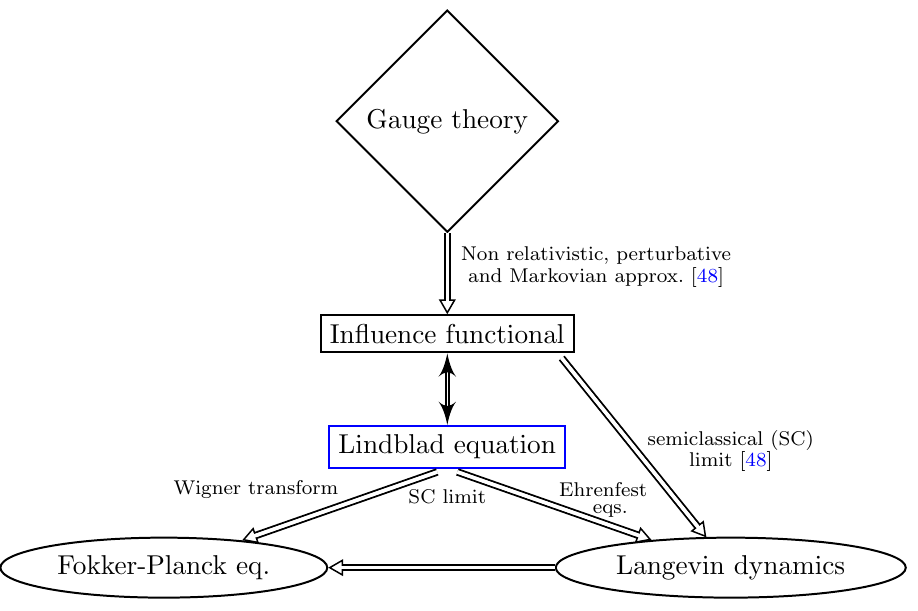
Figure 1 . Flow chart of both the steps performed in the previous work [48] and the ones followed in this project. In general, an in(cid:13)uence functional can be derived without the approximations indicated